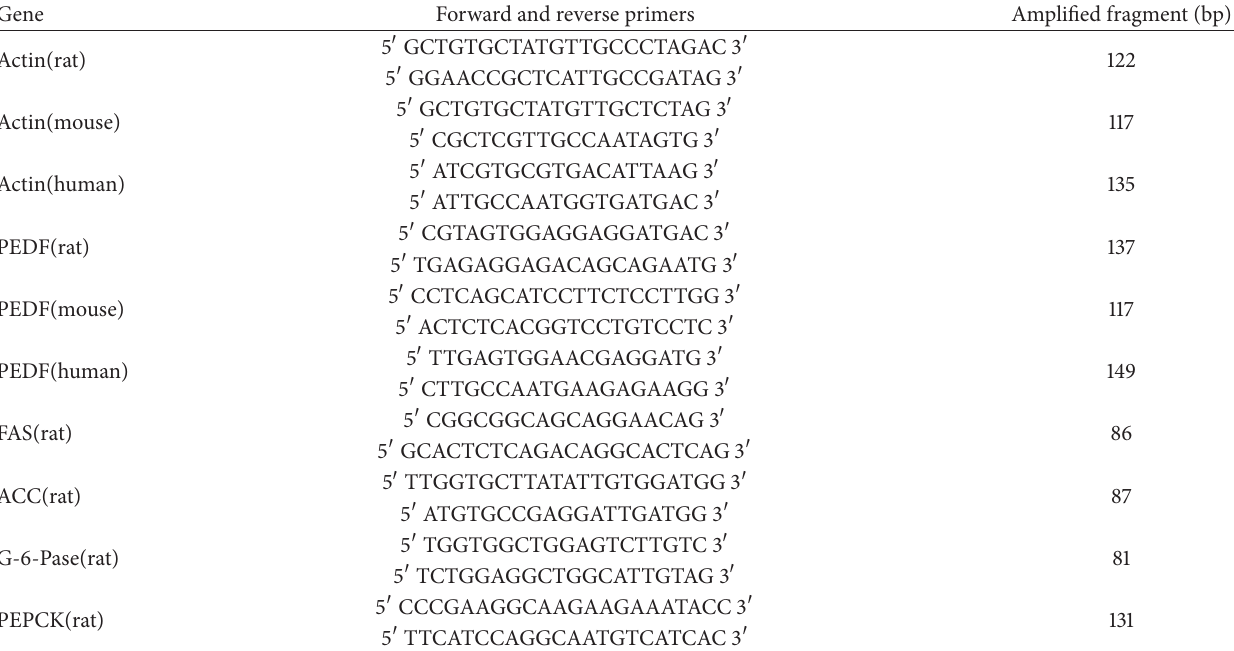
Table 1: Specific primers used for real-time